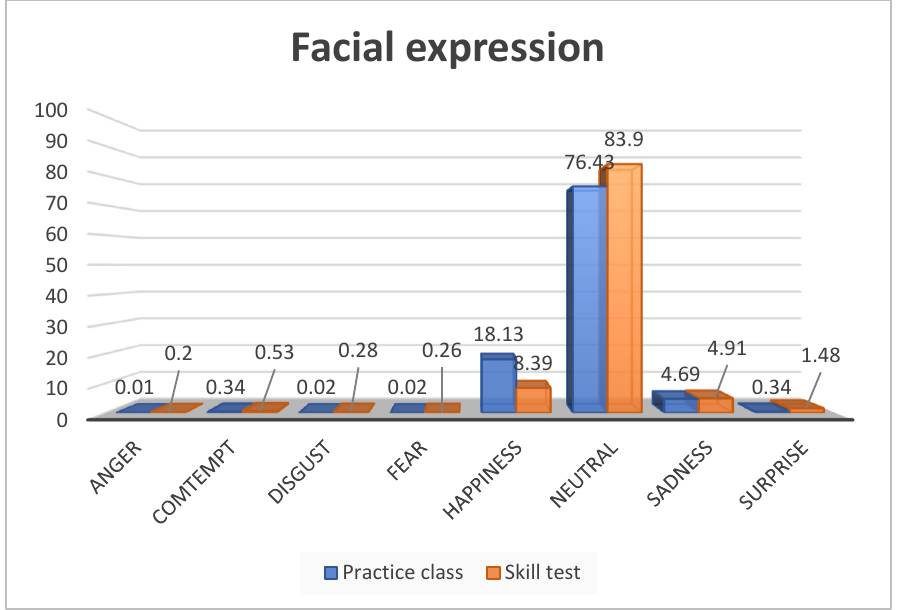
Figure 2. Comparison graph of facial expression subcategories. Table 1. Comparison of test anxiety, academic efficacy, and facial expression between practice class and skill test ( n =